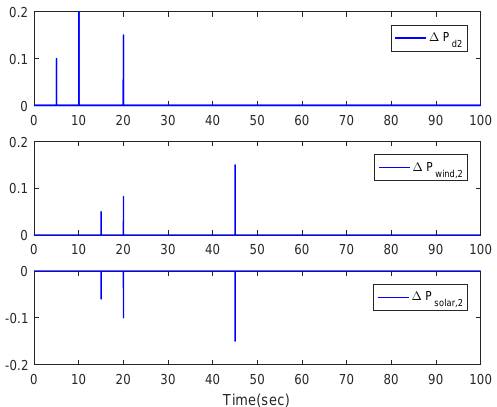
Figure 6. Multi-disturbances in the second area power system.